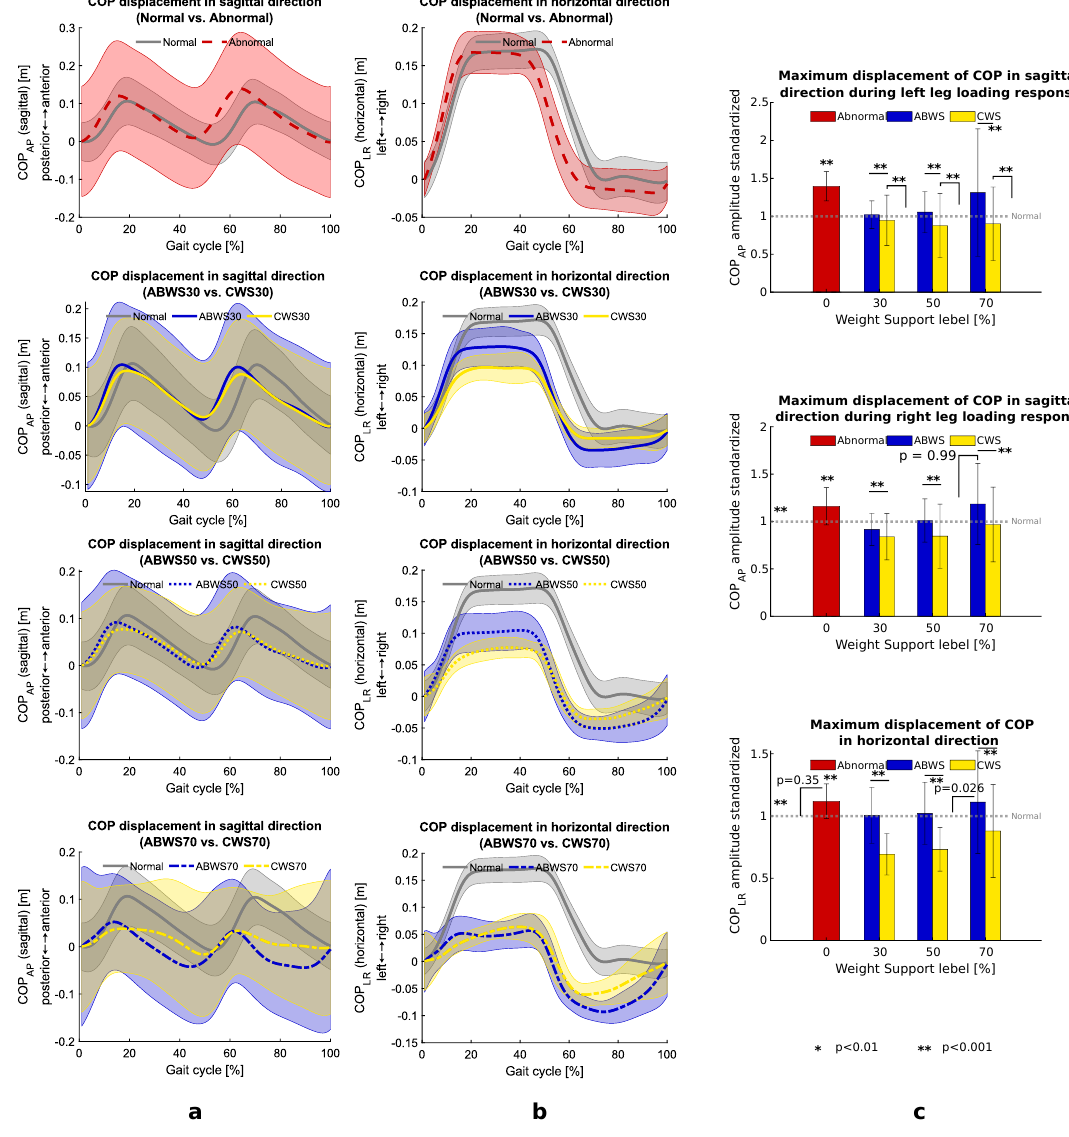
Figure 7. The analyzing of the COP trajectories in sagittal, horizontal direction, column ( a , b ) respectively. Comparison of the maximum displacements of COP while left leg response, right leg response and horizontal direction present on column ( c ). The significant value ( p ) was selected as 0.05. * and ** show that p is less than 0.01, and 0.001,